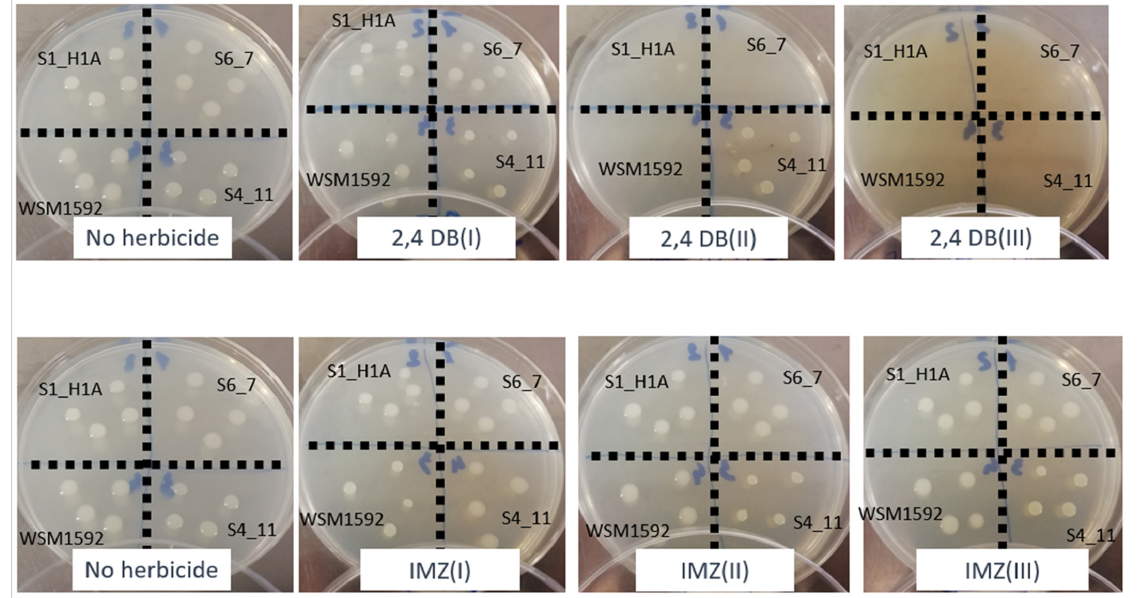
Figure 6. Influence of different concentrations of imazamox (IMZ) and 2,4-DB (DB) on the growth of different strain of R. sullae on YMA plates. IMZ(I), (II) and (III) refer to 3, 15, 150 µg IMZ g − 1 medium, respectively. DB(I), (II) and (III) refer to 100, 500, 5000 µg DB g − 1 medium, respectively.